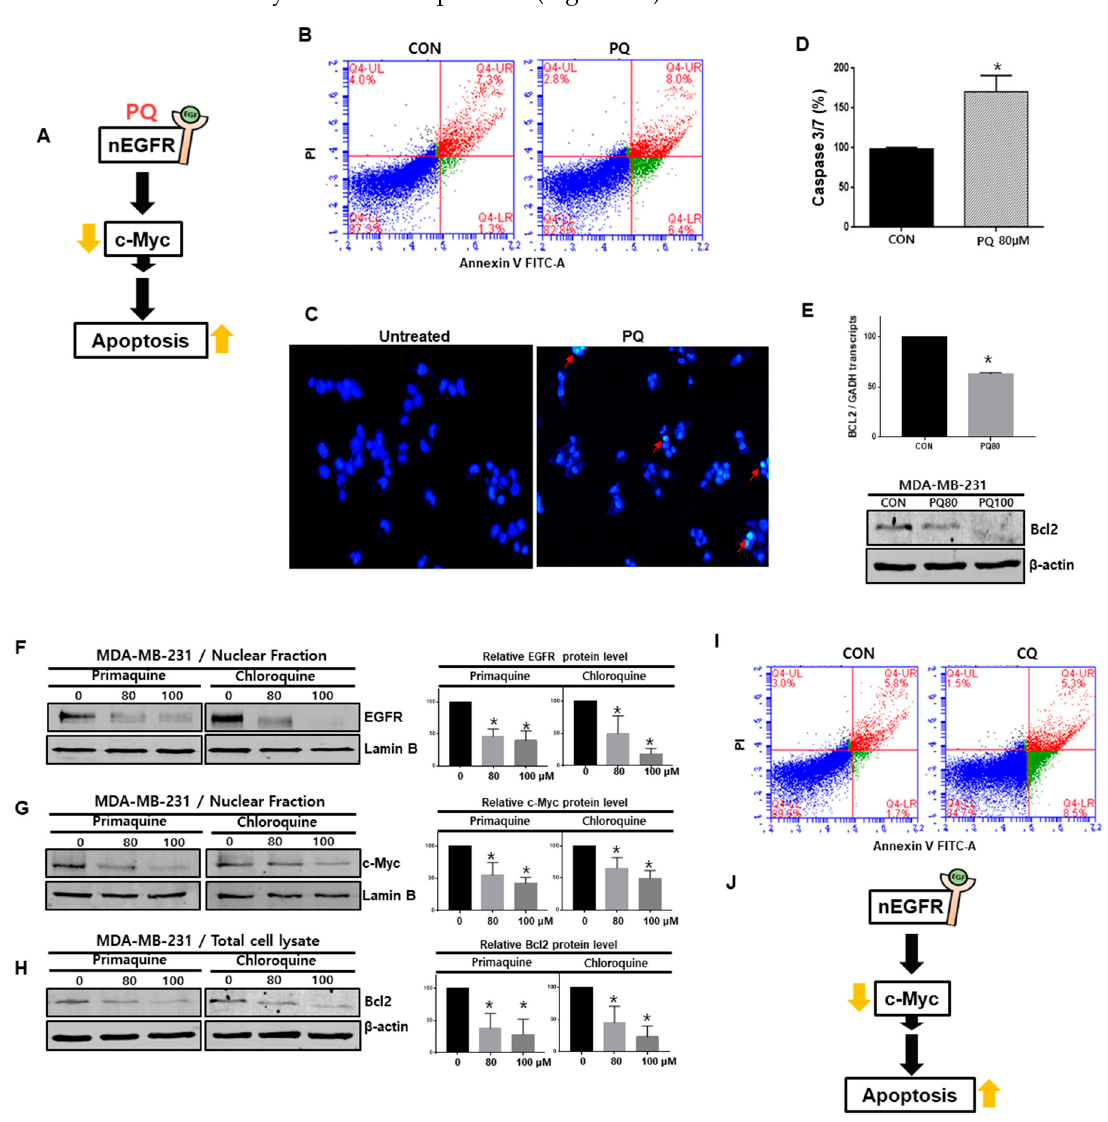
Figure 6. Primaquine and CQ induced the apoptosis of breast cancer through nEGFR and c-Myc regulation. ( A ) The proposed model for breast cancer cell death induced by primaquine. ( B ) Primaquine (80 µ M) induced the apoptosis of cancer cells. Cells undergoing primaquine-induced apoptosis were analyzed by using an annexin V-PI staining kit. ( C ) Analysis of apoptotic cancer cells by fluorescence staining. The nuclei of breast cancer cells were stained with Hoechst 33258 (magnification, × 100). The red arrows indicate apoptotic bodies. ( D ) The caspase-3/7 activity of breast cancer cells was determined with the Caspase-Gloss 3/7 kit. ( E ) Effect of primaquine (0, 80, and 100 µ M) on Bcl-2 protein levels in breast cancer cells. ( F – H ) Effect of primaquine and CQ (0, 80, and 100 µ M) on nEGFR, cMyc and Bcl-2 protein levels in breast cancer cells. ( I ) CQ (80 µ M) induced the apoptosis of cancer cells. Cells undergoing CQ-induced apoptosis were analyzed by using an annexin V-PI staining kit. ( J ) The proposed model for CQ-induced breast cancer cell death. The data are presented as the mean ± SD; n = 3; * indicates p < 0.05 vs.